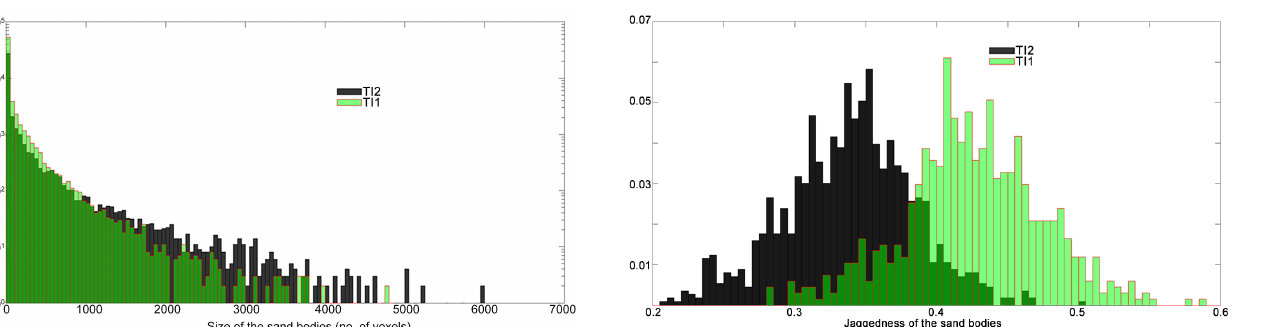
Figure 12. Sizes of the sand bodies of the unconditioned realiza- tions obtained by using the two different TIs shown in Fig. 10.